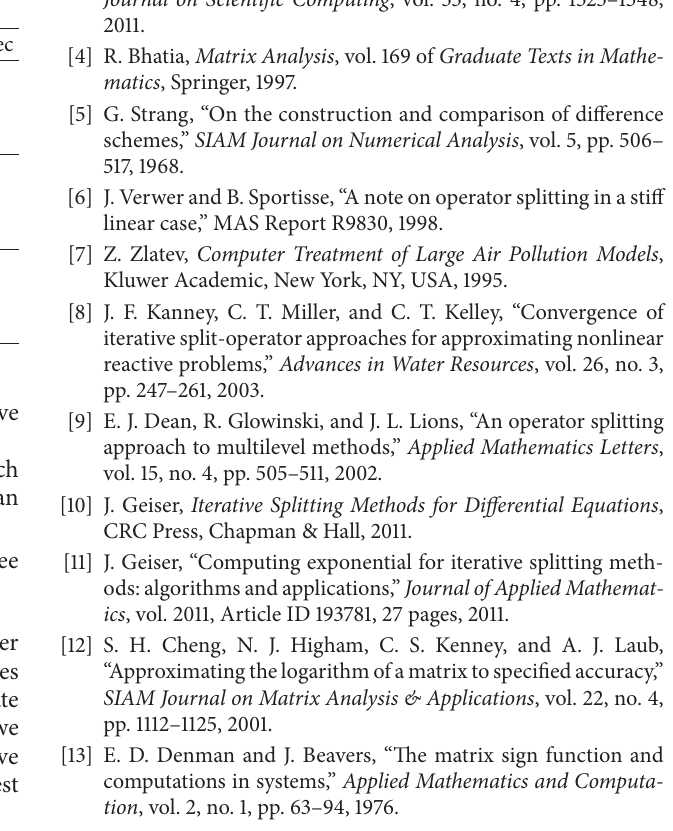
Table 4: The computational time of all three